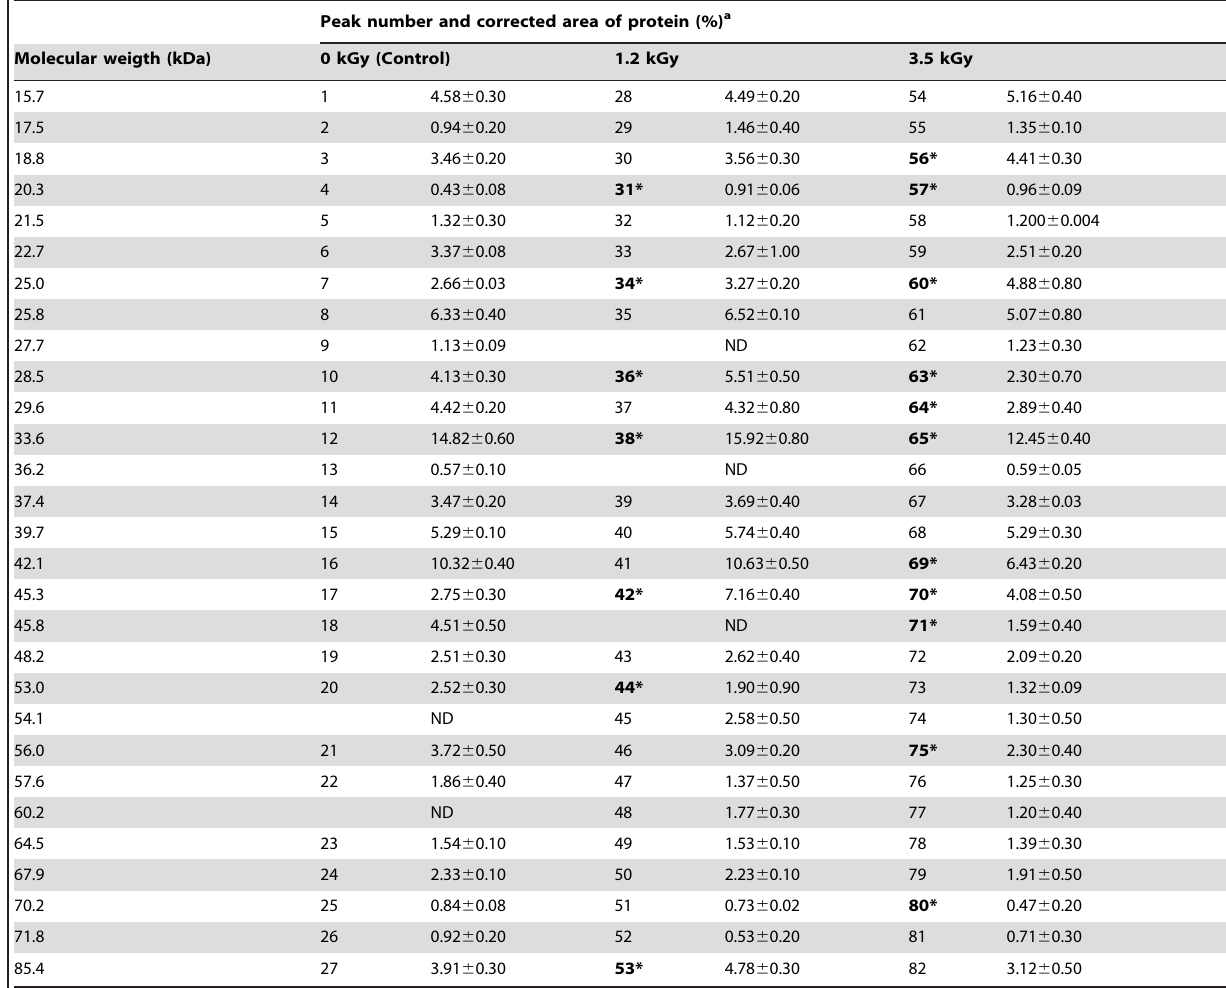
Table 1. Profiles of protein expression by Listeria monocytogenes at different doses of c -irradiation treatment.